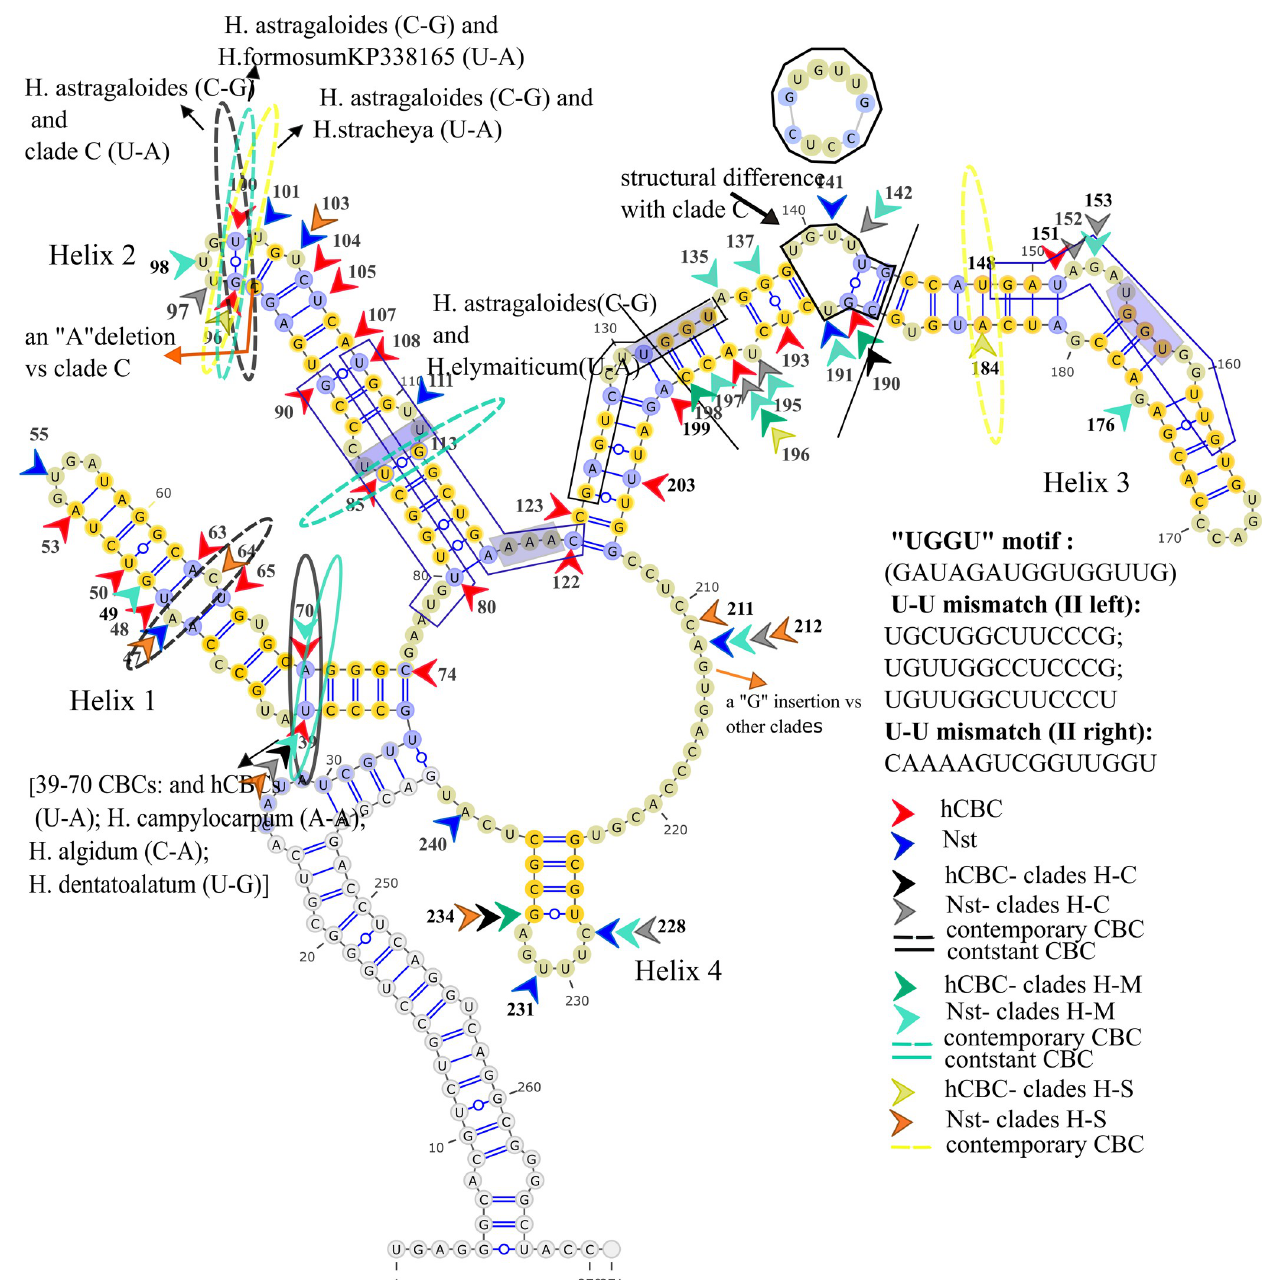
Fig 6. ITS2 Consensus secondary structure of H . sect. Hedysarum (clade H). Yellow flashes 100% conserved regions in the section.